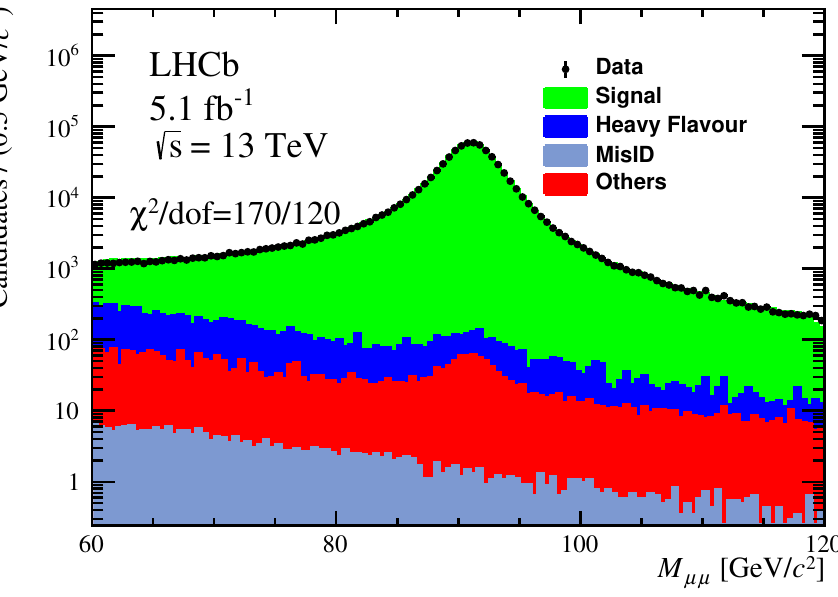
Figure 1 . Comparison of the invariant mass distribution between data and the sum of signal and background contributions for the selected Z → µ + µ −